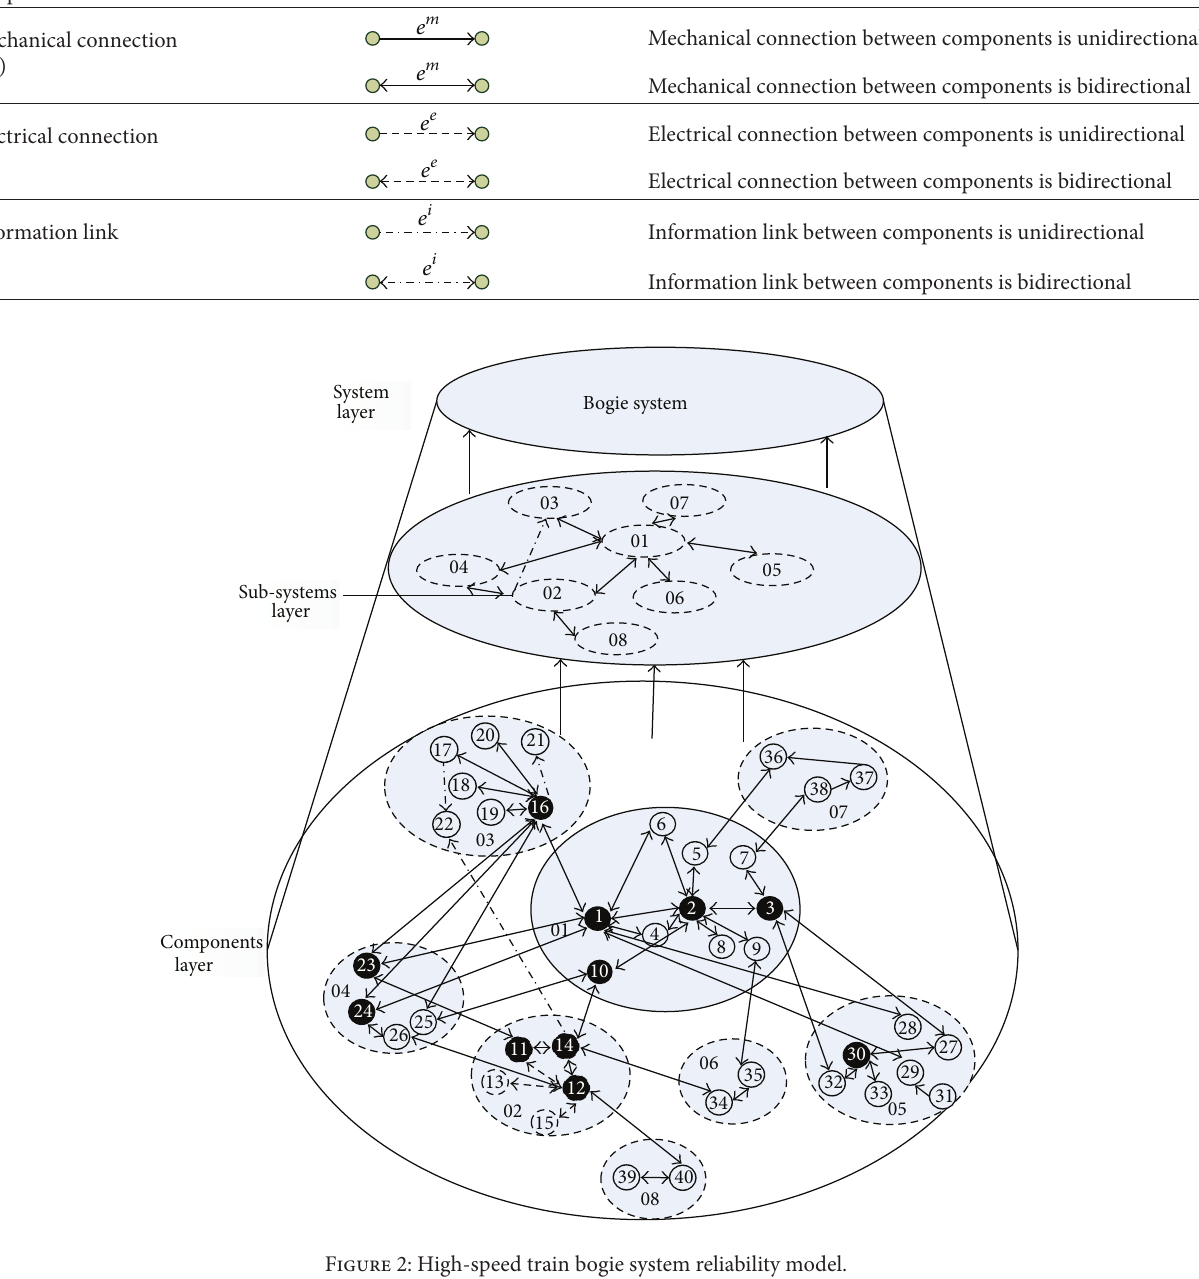
Figure 2: High-speed train bogie system reliability